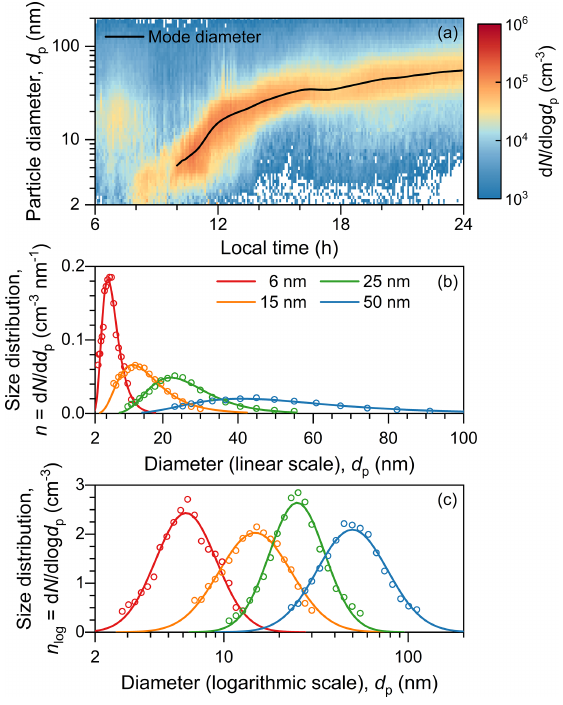
Figure 1. Evolution of aerosol size distribution in urban Beijing during an NPF event. Panel (a) shows the whole growth pattern, and panels (b) and (c) show the d N/ d d p and d N/ dlog d p , respec- tively, when growing new particles reached certain sizes. In pan- els (b) and (c) , the size distribution is normalized by dividing it by the fitted number concentration so that the area of every peak is equal to unity. The markers and lines are the measured and fit- ted distributions, respectively. The size distributions in panels (b) and (c) are identical to each other, though they are shown on differ- ent vertical axes and horizontal